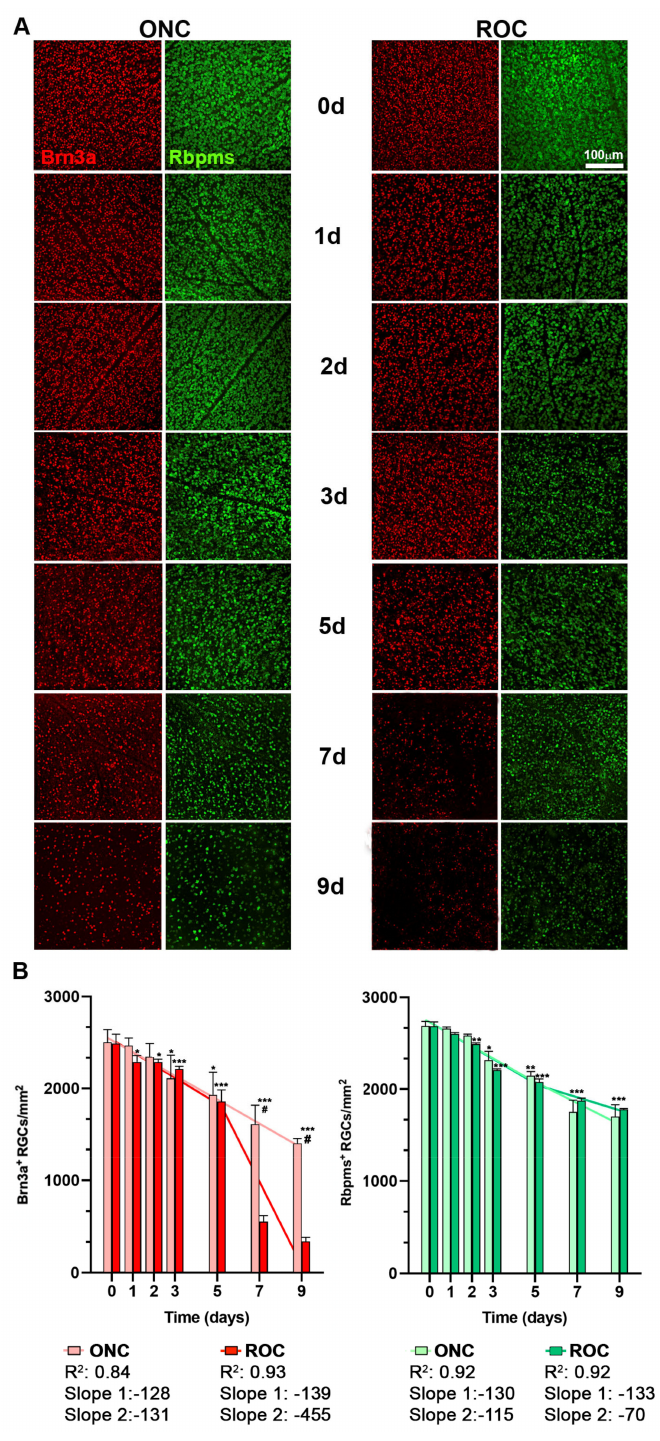
Figure 2. Course of retinal ganglion cell death in ROCs and after ONC. ( A ) Representative magnifica- tions from intact retinas (day 0) and retinas analyzed from 1 to 9 days after ROC and ONC showing Brn3a (red) and Rbpms (green) positive RGCs. ( B ) X- and Y-graphs (time versus cells) showing the mean ± SD density (cells/mm 2 ) of Brn3a + RGCs (left) and Rbpms + RGCs (right) in both groups. Time 0 represents data from control retinas. The linear regression was calculated in two phases (X0 at day 5). Slope 1 does not differ between models or markers. Slope 2 is significantly steeper in ROCs than after ONC for Brn3a, and after ONC than in ROCs for Rbpms ( p < 0.0001). * Intact vs. experimental (* p < 0.05, ** p < 0.01, *** p < 0.001, Kruskal–Wallis test, Dunn’s multiple comparisons test); # ONC vs. ROC (# p < 0.001, Mann–Whitney test). n = 4–6 retinas/group/time